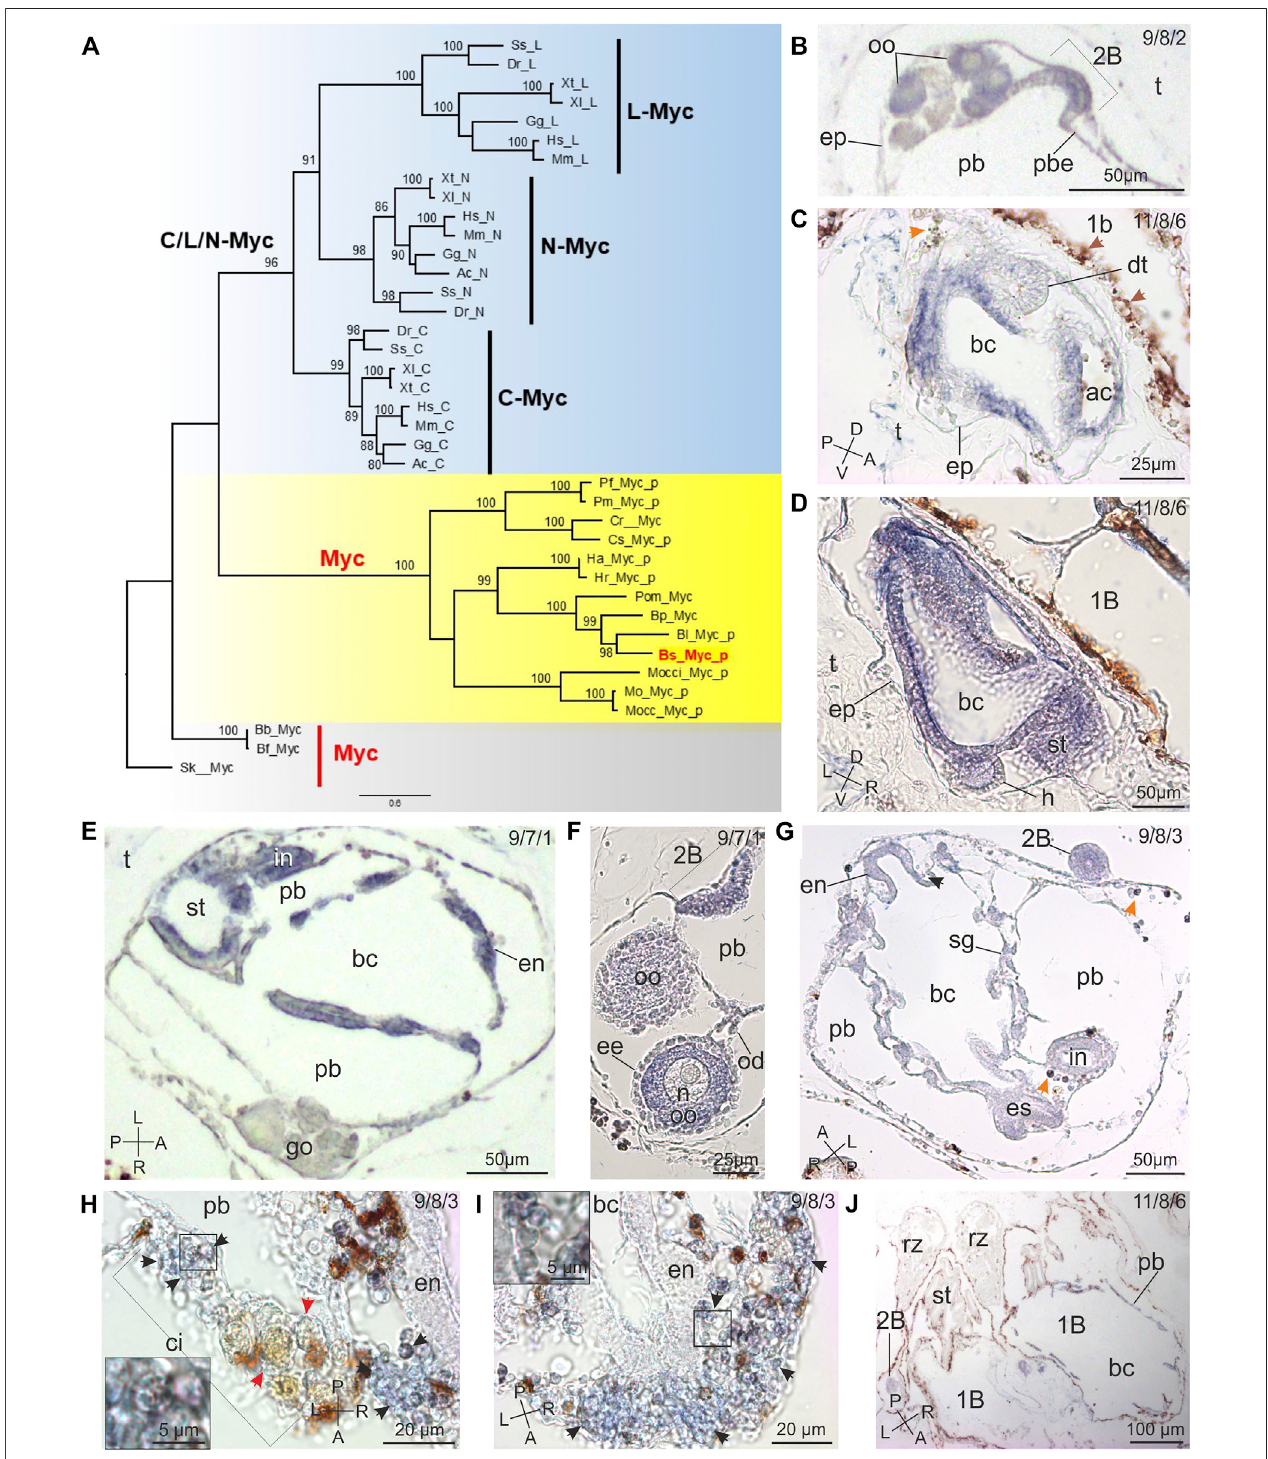
FIGURE 2 | Myc evolution and expression pattern in B. schlosseri . (A) ML evolutionary tree of the MYC family (978 amino acid sites; best- fi t substitution model JTT+G+I+F; bootstrap on 100 replicates; Myc of the echinoderm Strongylocentrotus purpuratus used as outgroup). Only bootstrap values ≥ 70% are shown near each node. Red: B. schlosseri sequence used in ISH; yellow: ascidians; light blue: vertebrates; grey: other deuterostomes. Sequence data are in Supplementary Table 2 . Sequences with the "_p" suf fi x were annotated ex novo or re-annotated in this study. Species classi fi cation is reported in Supplementary Table 1 , and species abbreviations are: Ac: Anolis carolinensis ; Am: Alligator mississippiensis ; Bb: Branchiostoma belcheri ; Bf: Branchiostoma fl oridae ; Bl: Botrylloides leachii ;